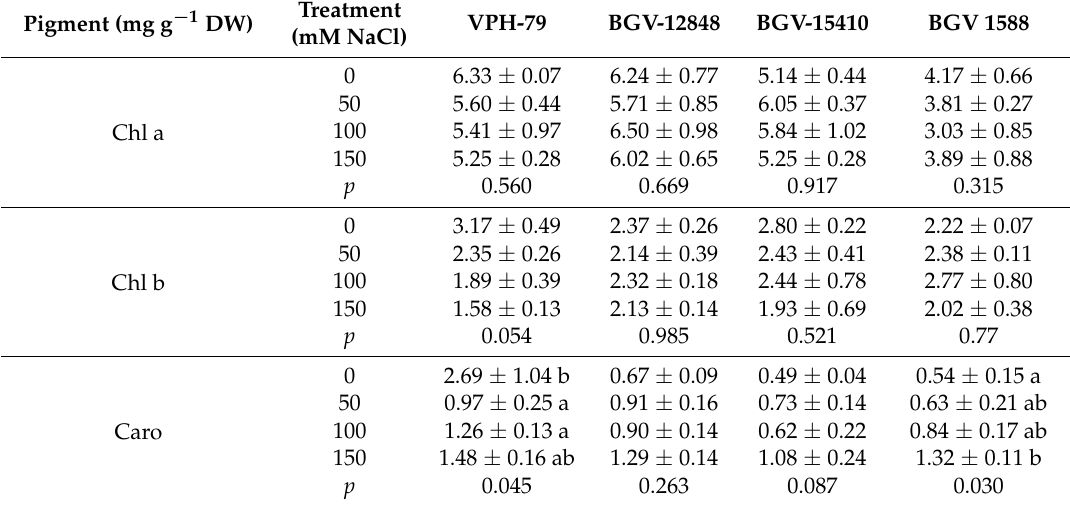
Table 3. Effect of salinity on photosynthetic pigments (Chl a, chlorophyll a; Chl b, chlorophyll b; Caro, carotenoids) concentrations in plants of the four Phaseolus lunatus cultivars. Means followed by SE ( n = 5). Different letters indicate significant differences within each cultivar according to Tukey’s test ( α = 0.05). p values according to one-way ANOVA.